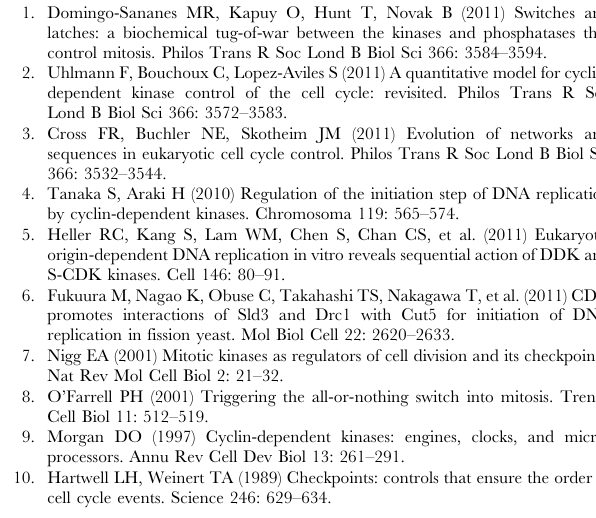
Figure S1 Survival of hpz1 D cells after UVC irradiation. Survival (with standard errors from three experiments shown), of wild-type or hpz1 D cells, after UVC-irradiation in G1, S or G2 phase. (TIF) Figure S2 Survival of hpz1 D cells after ionizing radia- tion. Threefold serially diluted cultures of the indicated strains were spotted on yeast extract agar (YEA) plates. The plates were either untreated or irradiated with 300 Gy. A checkpoint defective mutant ( rad26 D ) was included as a radiation-sensitive control strain. (JPG) Figure S3 Co-immunoprecipitation of Rad3 with Hpz1. Immunoblot showing Rad3-myc co-immunoprecipitated with Hpz1-HA. A total cell extract from G1-synchronized cells was used as a positive control for Rad3-myc presence ( + ). Beads without antibody was incubated with a cell extract from G1 cells to serve as a control for exclude Rad3-myc binding to the beads only (BO). (TIF) Figure S4 The cell cycle of wild-type and hpz1 D cells. Percentage of wild-type or hpz1 D in the different cell-cycle phases S, G2, or M-G1 in an exponentially growing culture. (TIF) Figure S5 PCB boxes in the promoter region of hpz1. A schematic display of the localization of putative PCB boxes (green) in the promoter region of hpz1 relative to its transcription start point and the open reading frame. (TIF) Table S1 Strains used in this